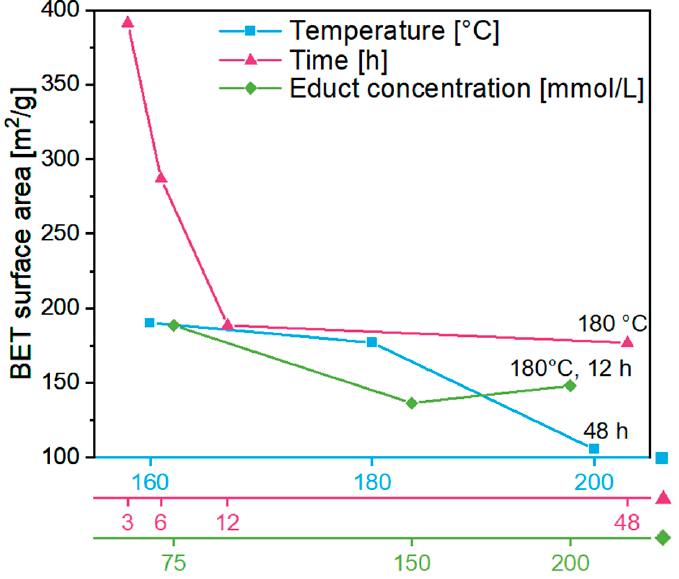
Figure 4. BET surface area as a function of different synthesis parameters. Effect of synthesis temperature at a duration of 48 h (blue squares), the effect of duration at a temperature of 180 ◦ C (rose triangles) and the effect of In(acac) 3 concentration at 180 ◦ C for 12 h (green diamonds).